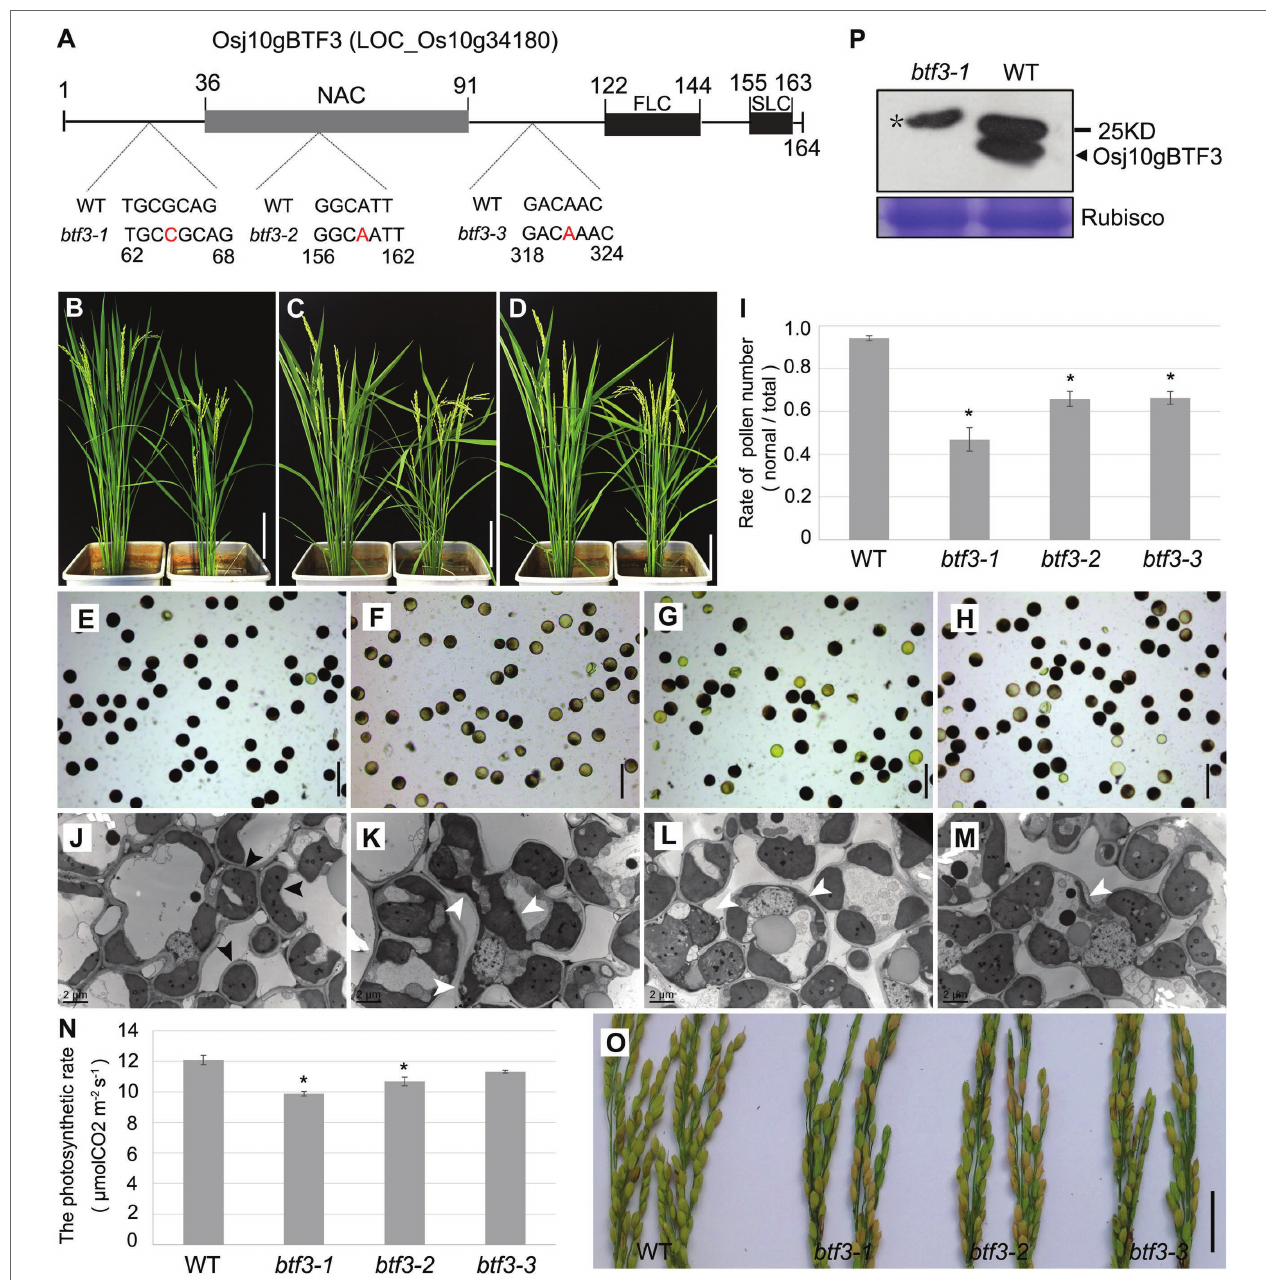
FIGURE 1 | Loss of Osj10gBTF3 affects pollen and chloroplast development in rice. (A) Schematic of domain structure of Osj10gBTF3 and mutation sites of btf3 mutants. FLC and SLC indicate the first and second complexity domains, respectively. (B–D) Comparison of plant height between WT plants (left) and the btf3-1 (B) , btf3-2 (C) , and btf3-3 (D) mutants (right). (E–H) KI-I 2 staining of pollen grains of WT (E) and btf3-1 (F) , btf3-2 (G) , and btf3-3 (H) mutants. (I) The proportion of normal pollens checked by KI-I 2 -staining in WT and btf3-1 , btf3-2 , and btf3-3 mutants. *indicates p < 0.05. (J) to (M) Comparison of chloroplast in the leaves between WT and btf3-1 , btf3-2 , and btf3-3 mutants (TEM). Black and white arrows indicate the normal and abnormal chloroplasts, respectively. (N) Comparison of photosynthetic rate between WT and btf3-1 , btf3-2 , and btf3-3 mutants. Fifteen plants were selected for each material to measure the photosynthetic rate. *indicates p < 0.05. (O) Comparison of panicles between WT (left) and btf3-1 , btf3-2 , and btf3-3 mutants (right) at the maturing stage. Compared with WT, the number of grains with normal seeds-setting (yellow) were much fewer in btf3-1 , btf3-2 , and btf3-3 mutants. (P) Western blot analysis of Osj10gBTF3 protein level in WT and the btf3-1 mutant. Star(*) indicates the non-specific band. Scale bars: 20 cm in (B–D) , 100 μ m in (E–H) , and 5 cm in (O)